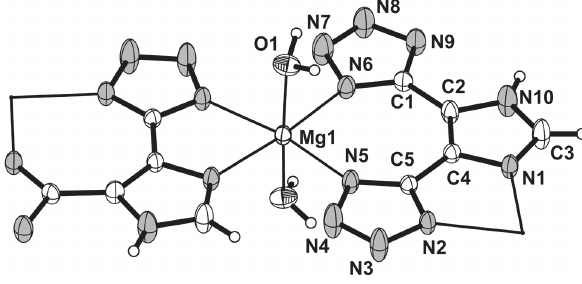
Table 1: Data collection and handling.